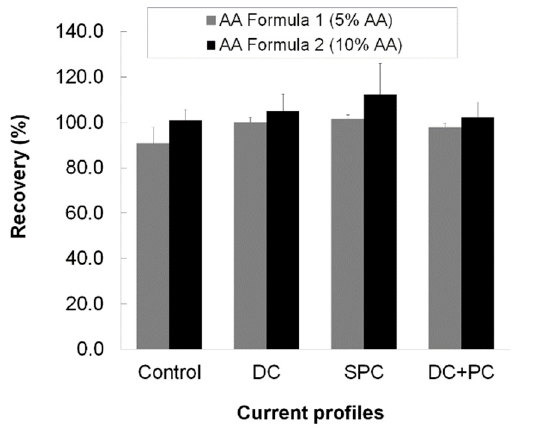
Figure 3. Stability of AA in the presence of the different current profiles.